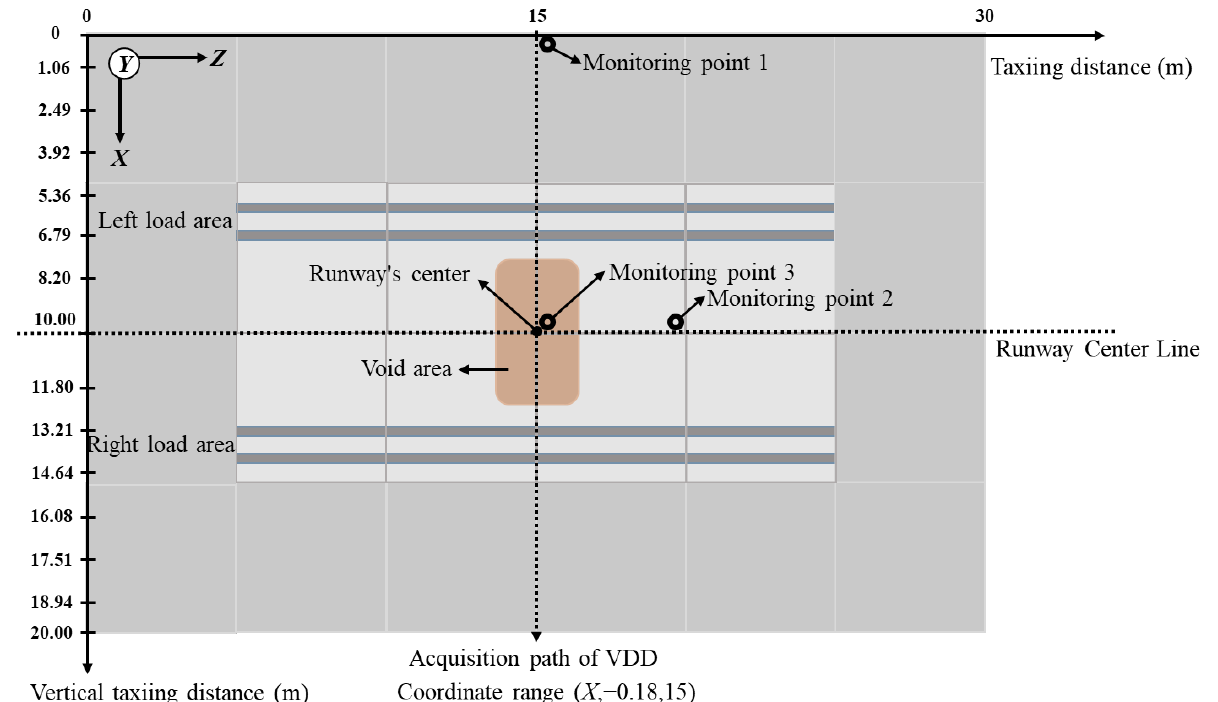
Figure 7. Void mode and mesh generation of model.